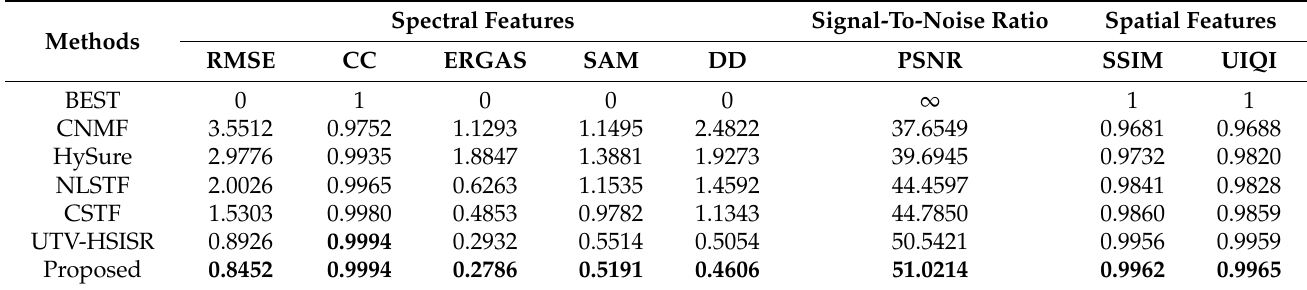
Table 4. Quality evaluation for Sand Lake